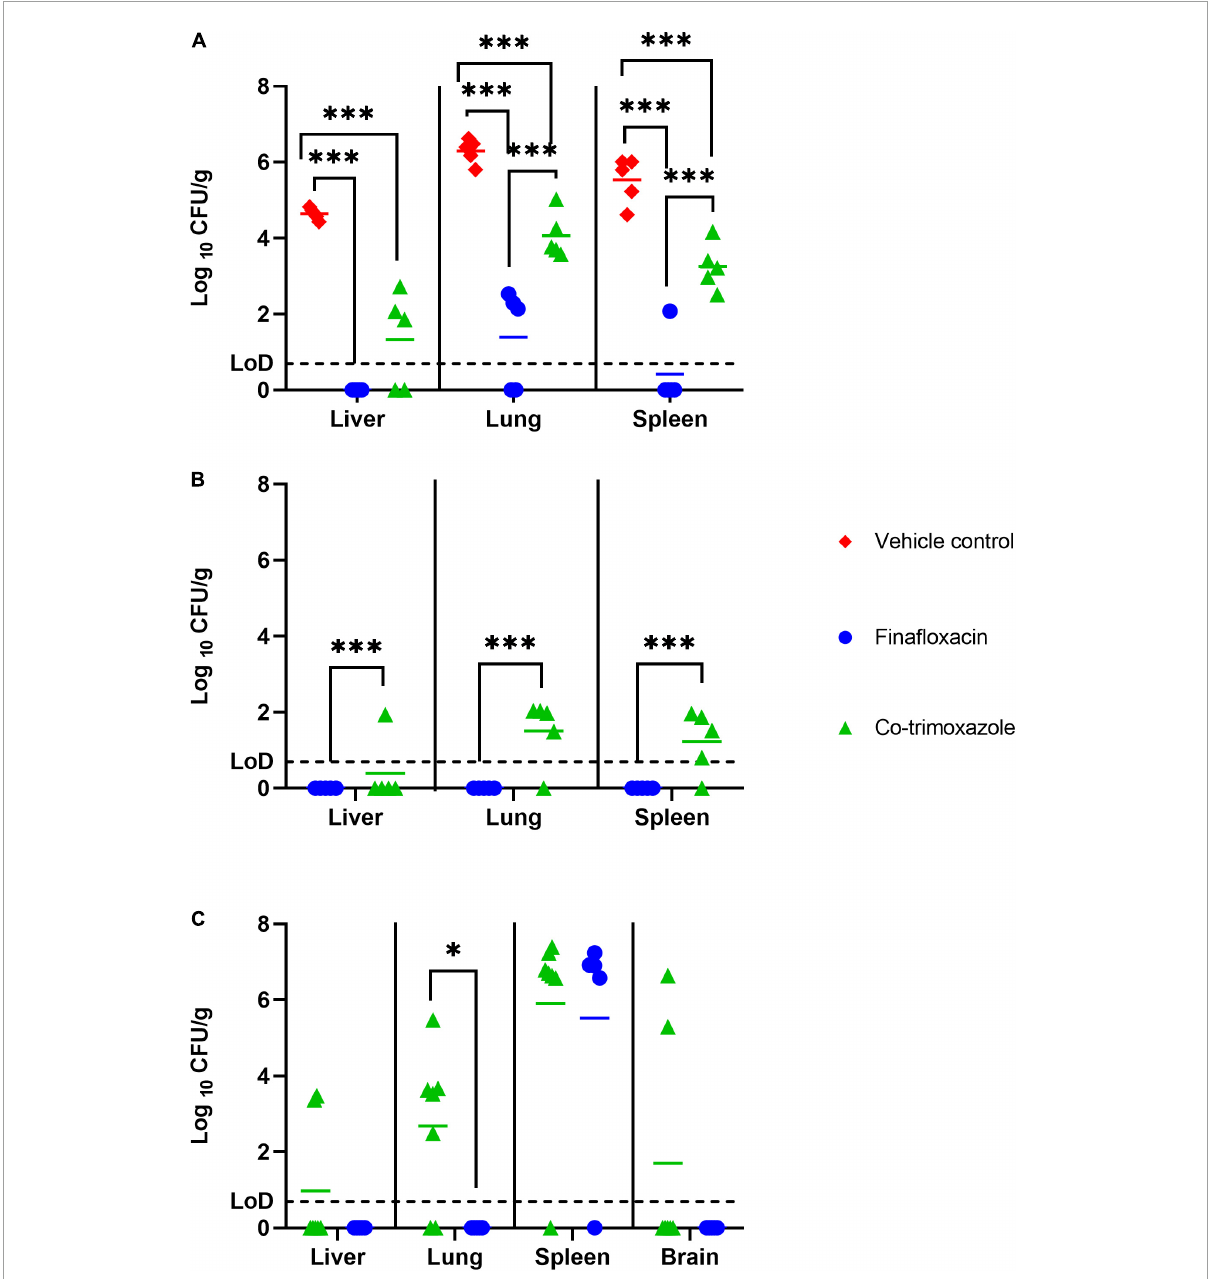
FIGURE2 The bacterial load in organs of mice challenged with B. mallei and treated with antibiotics. Bacterial counts (CFU/g) in the spleen, livers and lungs of mice following 1 day of antibiotic treatment (A) , 14 days of antibiotic treatment (B) or at the end of study day 65 (brains also harvested) (C) . Therapy was initiated at 24 h post-challenge and continued for 14 days. Treatment was with finafloxacin (37.5 mg/kg) every 8 h or co-trimoxazole (78 mg/kg) every 12 h delivered by the oral route. LoD, limit of detection *** p < 0.001, * p <